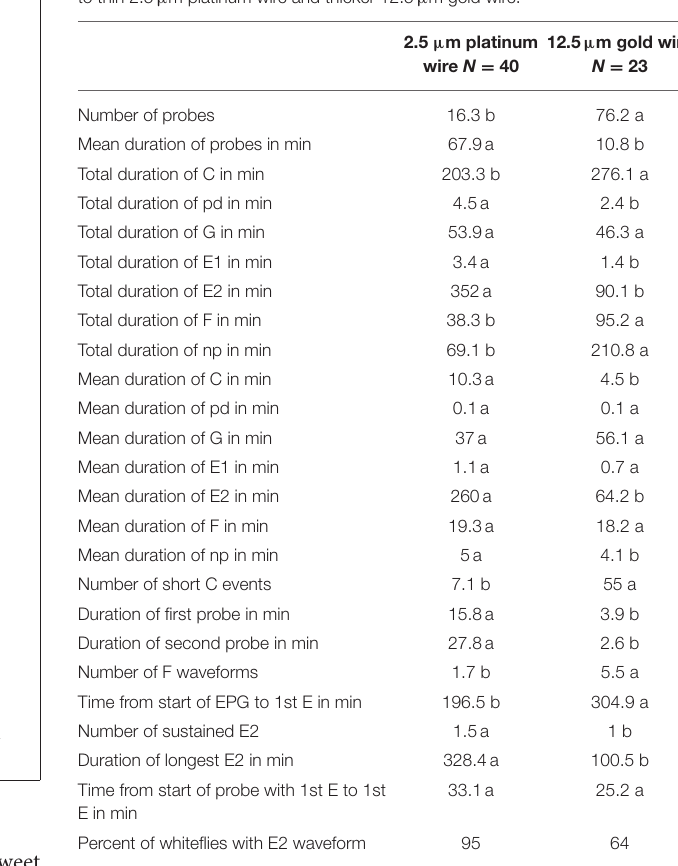
TABLE 3 | EPG parameters of SSA1-SG3 whiteflies feeding on cassava tethered to thin 2.5 µ m platinum wire and thicker 12.5 µ m gold